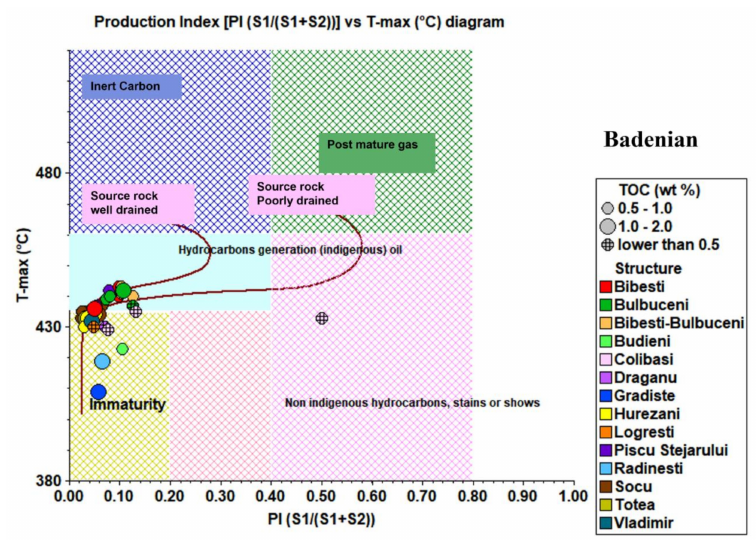
Figure 14. Production Index (PI) vs. T max ( ◦ C) diagram, showing the hydrocarbon generation zone.